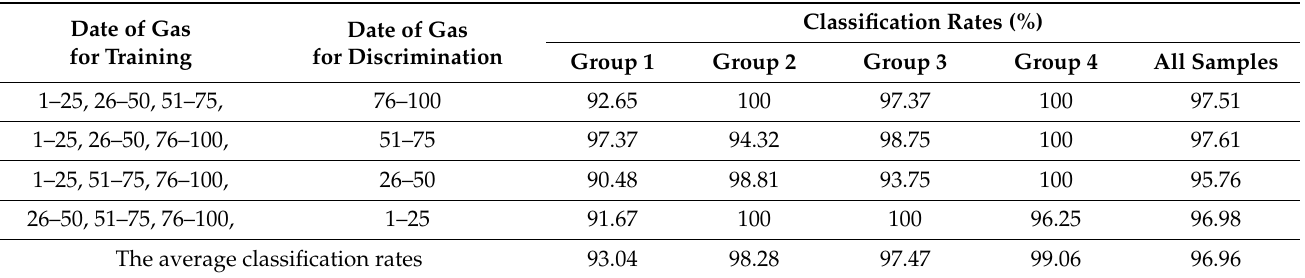
Figure 11. ( a ) PCA score plots of the array optimization sensors, ( b ) Fisher discriminant analysis results of all subsamples. Table 2. Classification rates of FDA (groups 1–4 represent benzene, toluene, xylene, and formalde- hyde,